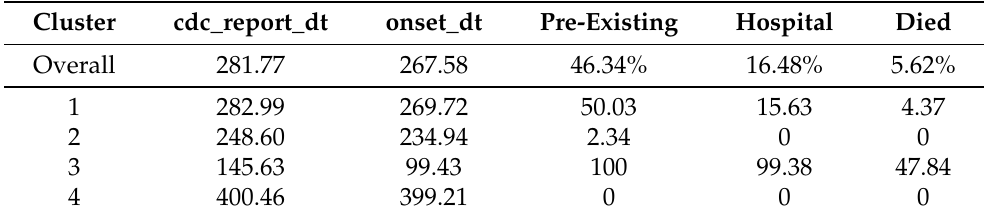
Table 4. Percentage of individuals who fall into health categories for overall sample of 10,000 and for each of the four clusters. Given as percentages. For the first two features, the number is not a percent, but the mean value.